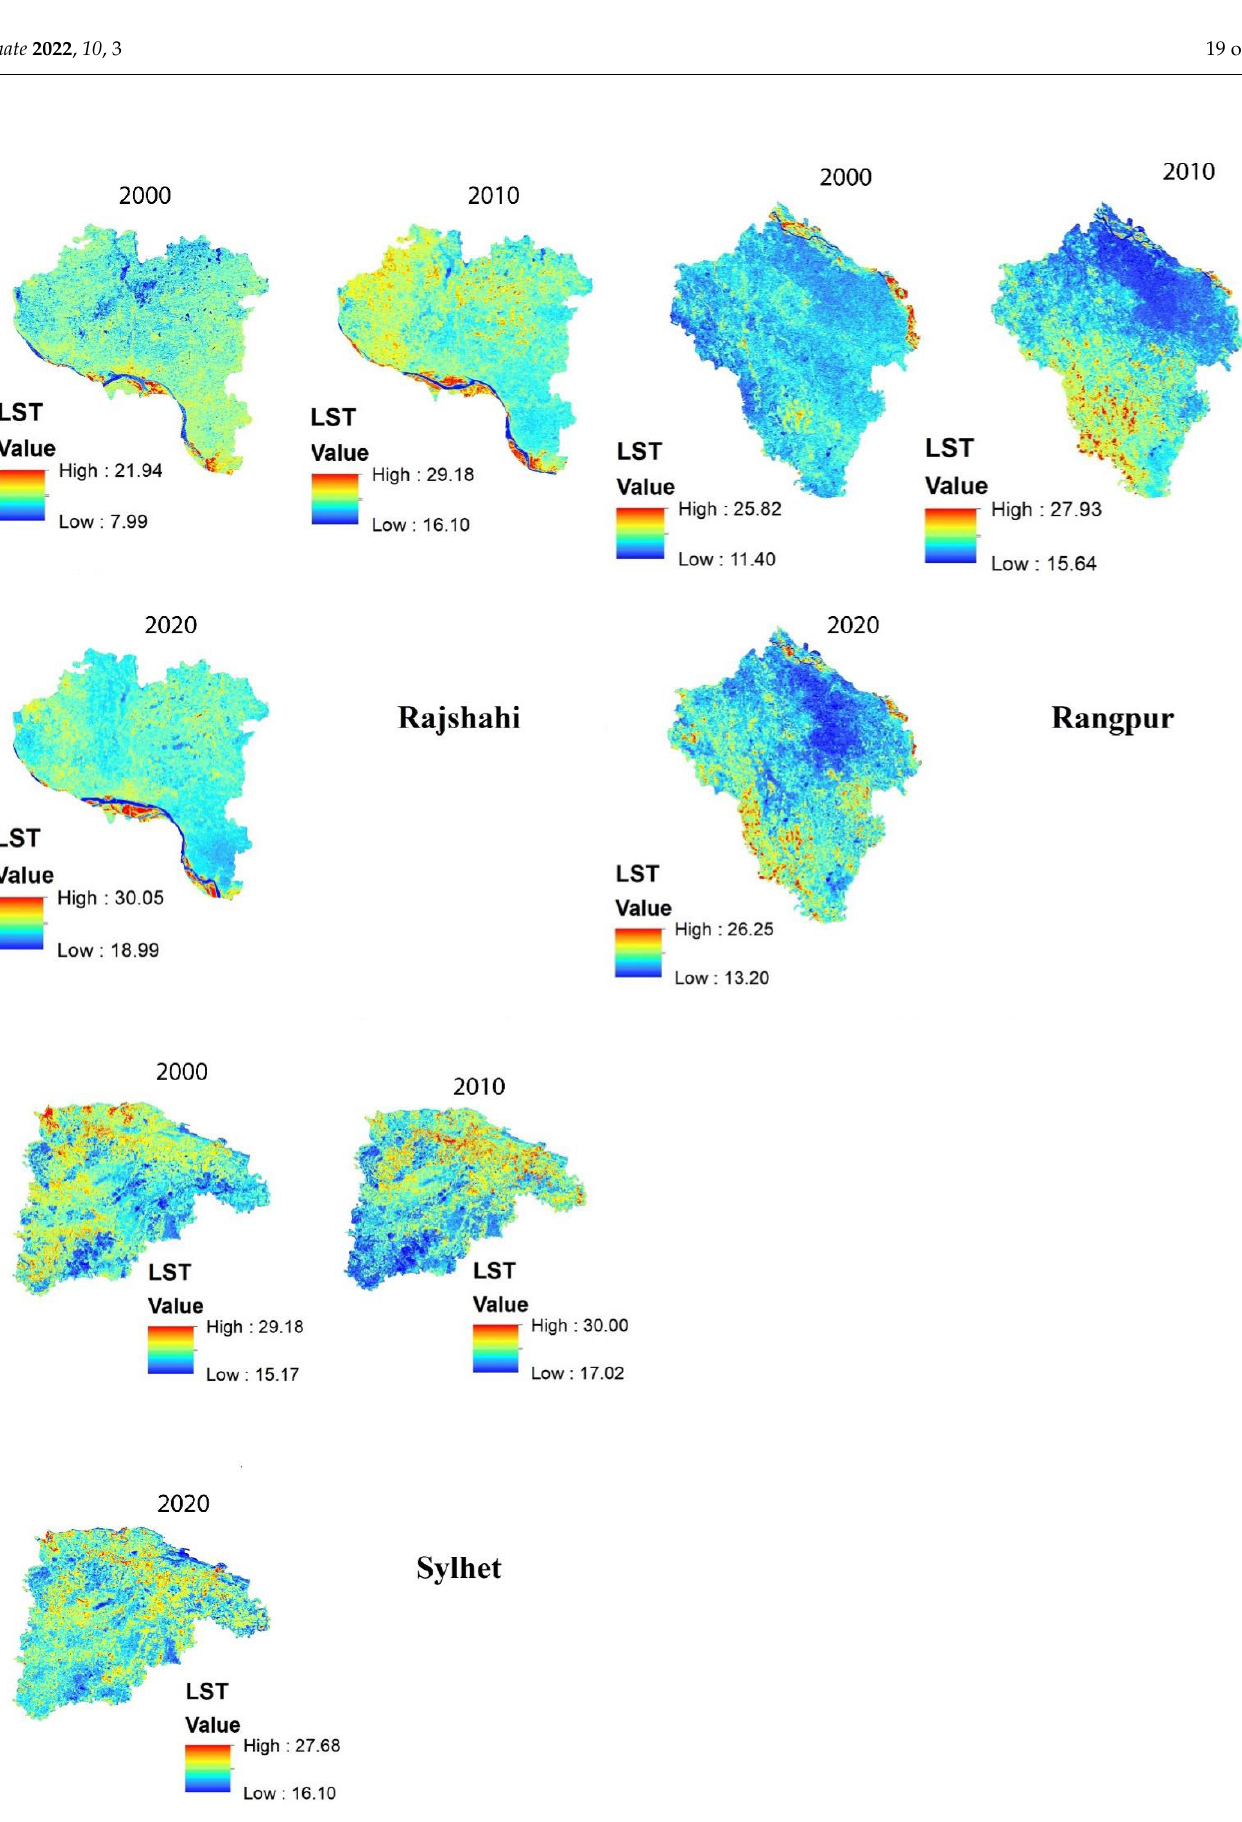
Figure 6. Spatiotemporal distributions of LST in seven districts of Bangladesh during 2000 – 2020.